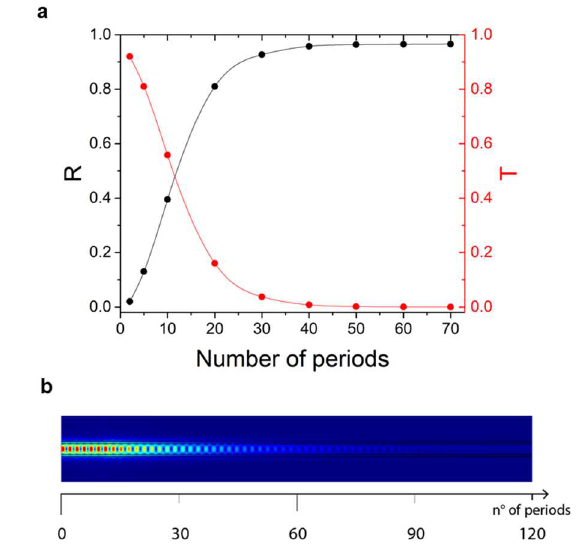
Fig. 5. ( a ) The trend of the reflection and transmission coefficients as a function of the number of periods, ( b ) the norm of the electric field along the longitudinal cut plane.